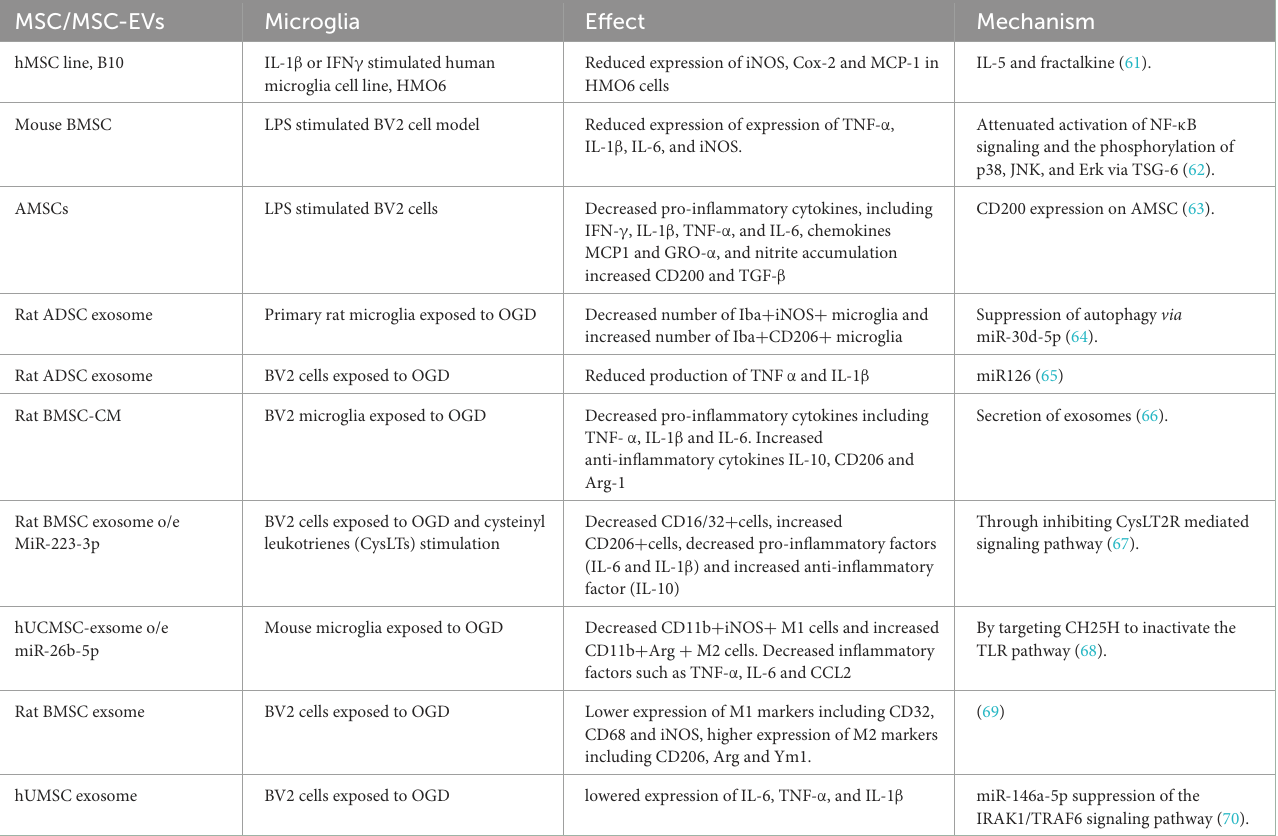
TABLE 1 MSC modulating microglial activation and polarization in vitro .